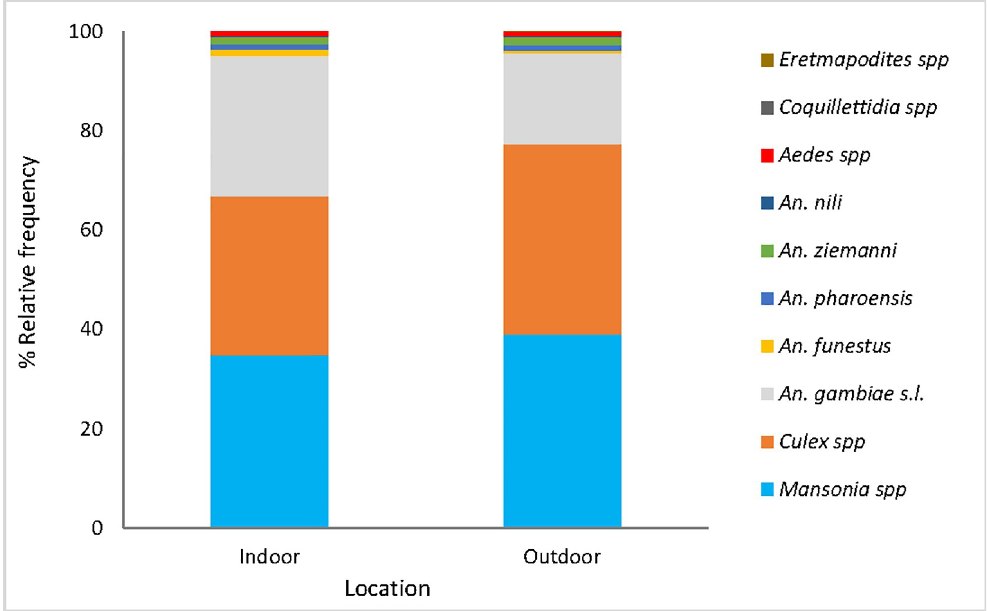
Fig 2. Mosquito species composition in the study area.